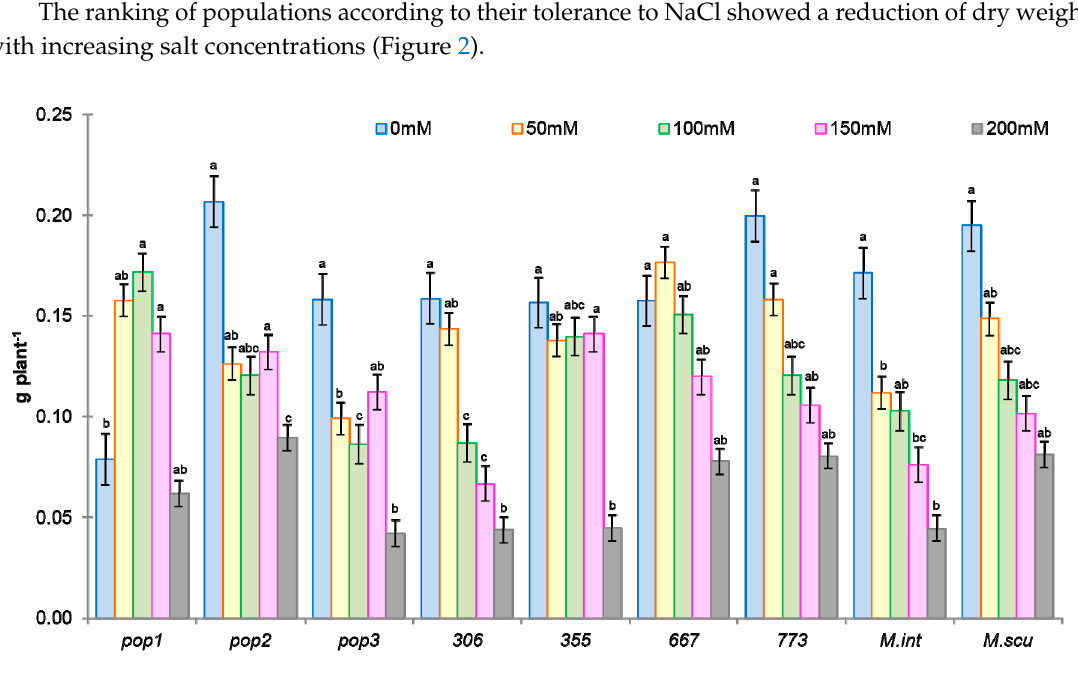
Figure 2. Effect of different concentrations of salt stress (0, 50, 100, 150, 200 mM NaCl) on DW (g plant - 1 ) of the seven populations of M. ciliaris ( Pop1, Pop2, Pop3, 306, 355, 667, 773 ) compared to one population of M. intertexta ( M. int ) and one population of M. scutellata ( M. scut ) The means are averages of 25 plants (5 plants/n=5 repetitions for each salt treatment). The standard deviation annotated by different lower-case letters in the same stress type indicate significant differences at p < 0.05, Tukey’s post hoc test.